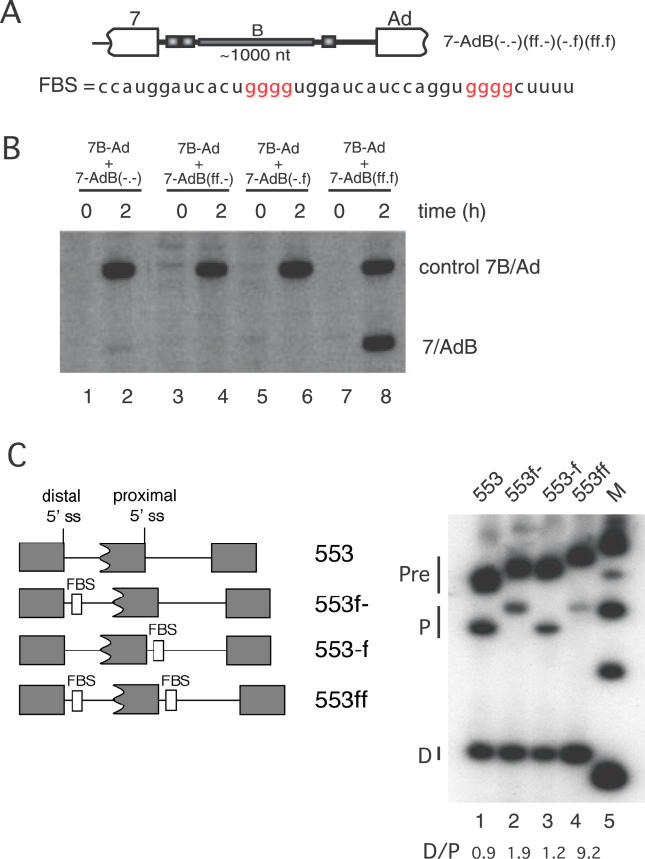
Binding Sites for hnRNP F/H Proteins Stimulate the Splicing of an Enlarged Intron and Modulate 5′ Splice-Site Selection(A) Structure of the pre-mRNA containing the enlarged intron (lambda insert B). The FBS was as described previously [29]. The first 6 nt of the FBS are derived from a NcoI site used for cloning purposes.(B) The control 7B-Ad pre-mRNA (8.7 pM) and the 7-AdB pre-mRNAs (85 pM) containing either no FBS (−.−), two FBS at the upstream position (ff.−), one FBS at the downstream position (−.f), or FBS at both positions (ff.f) were co-incubated for the times indicated (in hours) in a HeLa nuclear extract. A RT-PCR assay was performed to amplify simultaneously spliced mRNAs derived from 7B-Ad or the 7-AdB derivatives.(C) Activity of FBS in 5′ splice-site selection. The structure of the pre-mRNA containing an FBS at one or both positions is shown on the right. The pre-mRNAs were incubated in a HeLa extract for 2 h. A RT-PCR assay was performed to amplify splicing products from splicing mixtures. M indicates molecular-weight markers. The position of the products generated from the use of the distal (D) and proximal (P) 5′ splice sites, as well as from the pre-mRNAs (Pre), is shown. The distal–proximal ratio of products (D/P) is indicated below the lane number.